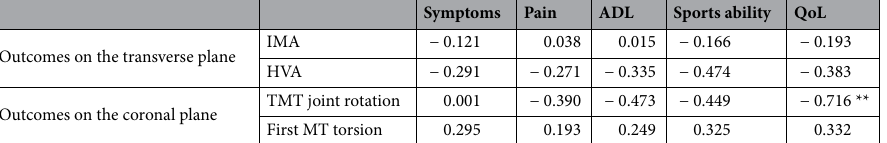
Table 3. The relation between foot-related functions and deformities on different planes. *The correlation is significant with p-value < 0.05. **The correlation is significant with p-value <